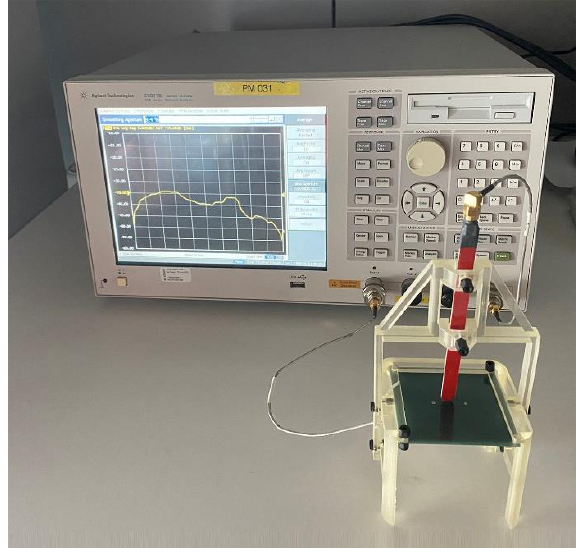
Figure 8. Measurement